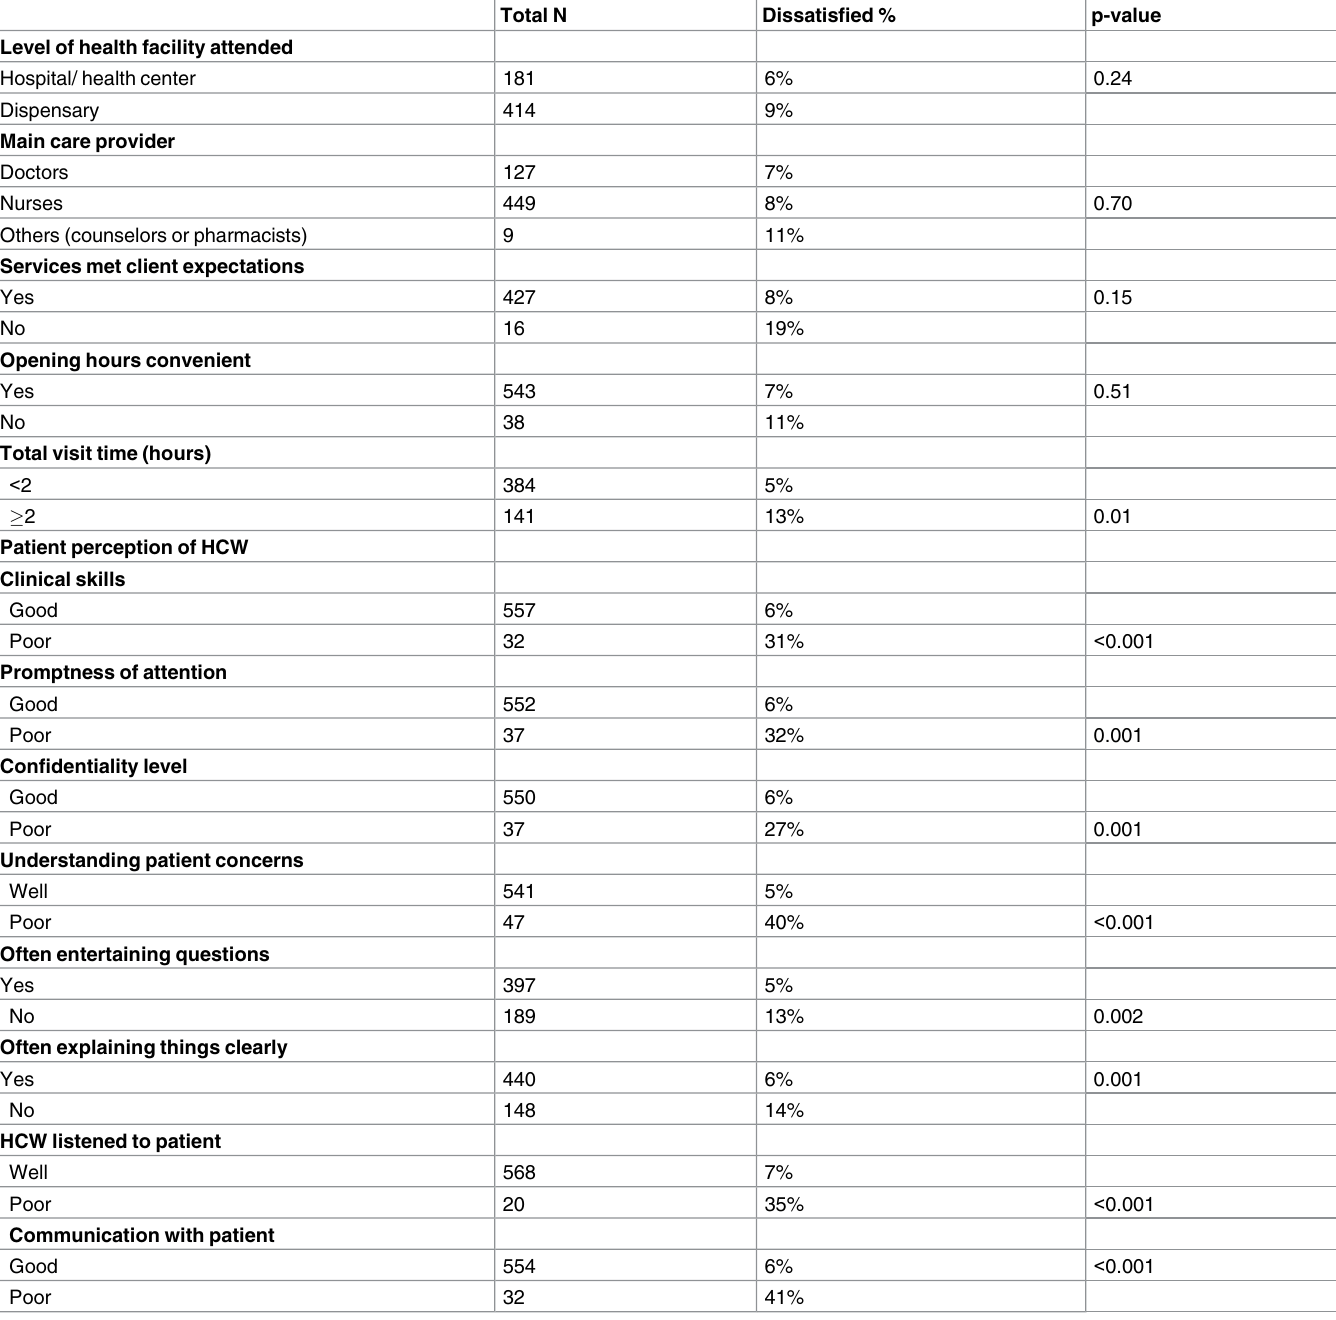
Table 2. Patient ratings of their dissatisfaction with PMTCT servicesaccording to health facility